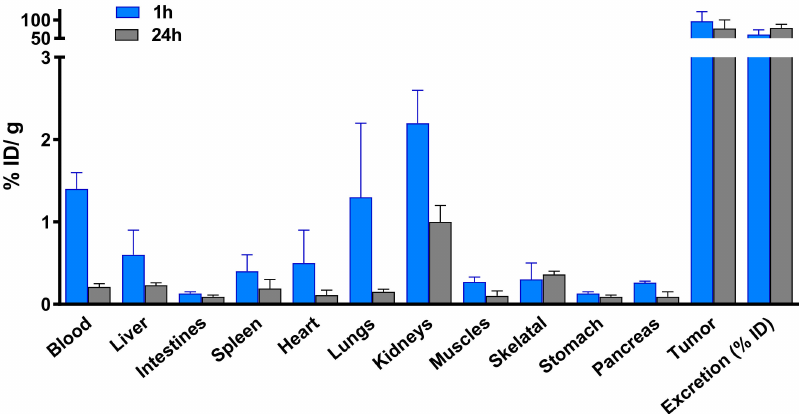
Figure 5. Biodistribution of 67 Ga-AuNP-Gd-BBN in PC3 xenograft Balb / c mice, after 1 h and 24 h intratumoral administration. Results are expressed as mean ± SD (n =